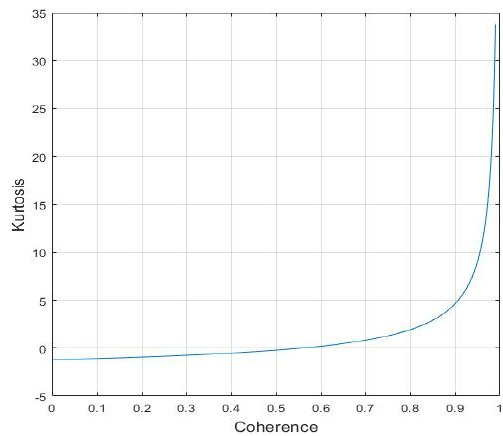
Figure 3. The kurtosis of interferometric